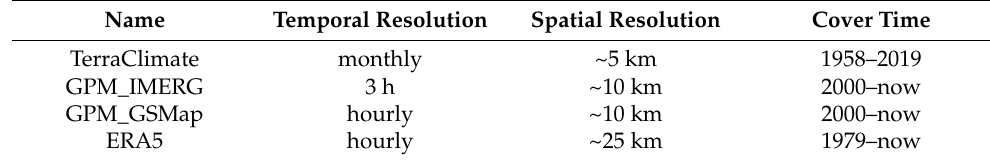
Table 1. Attributes of precipitation reanalysis